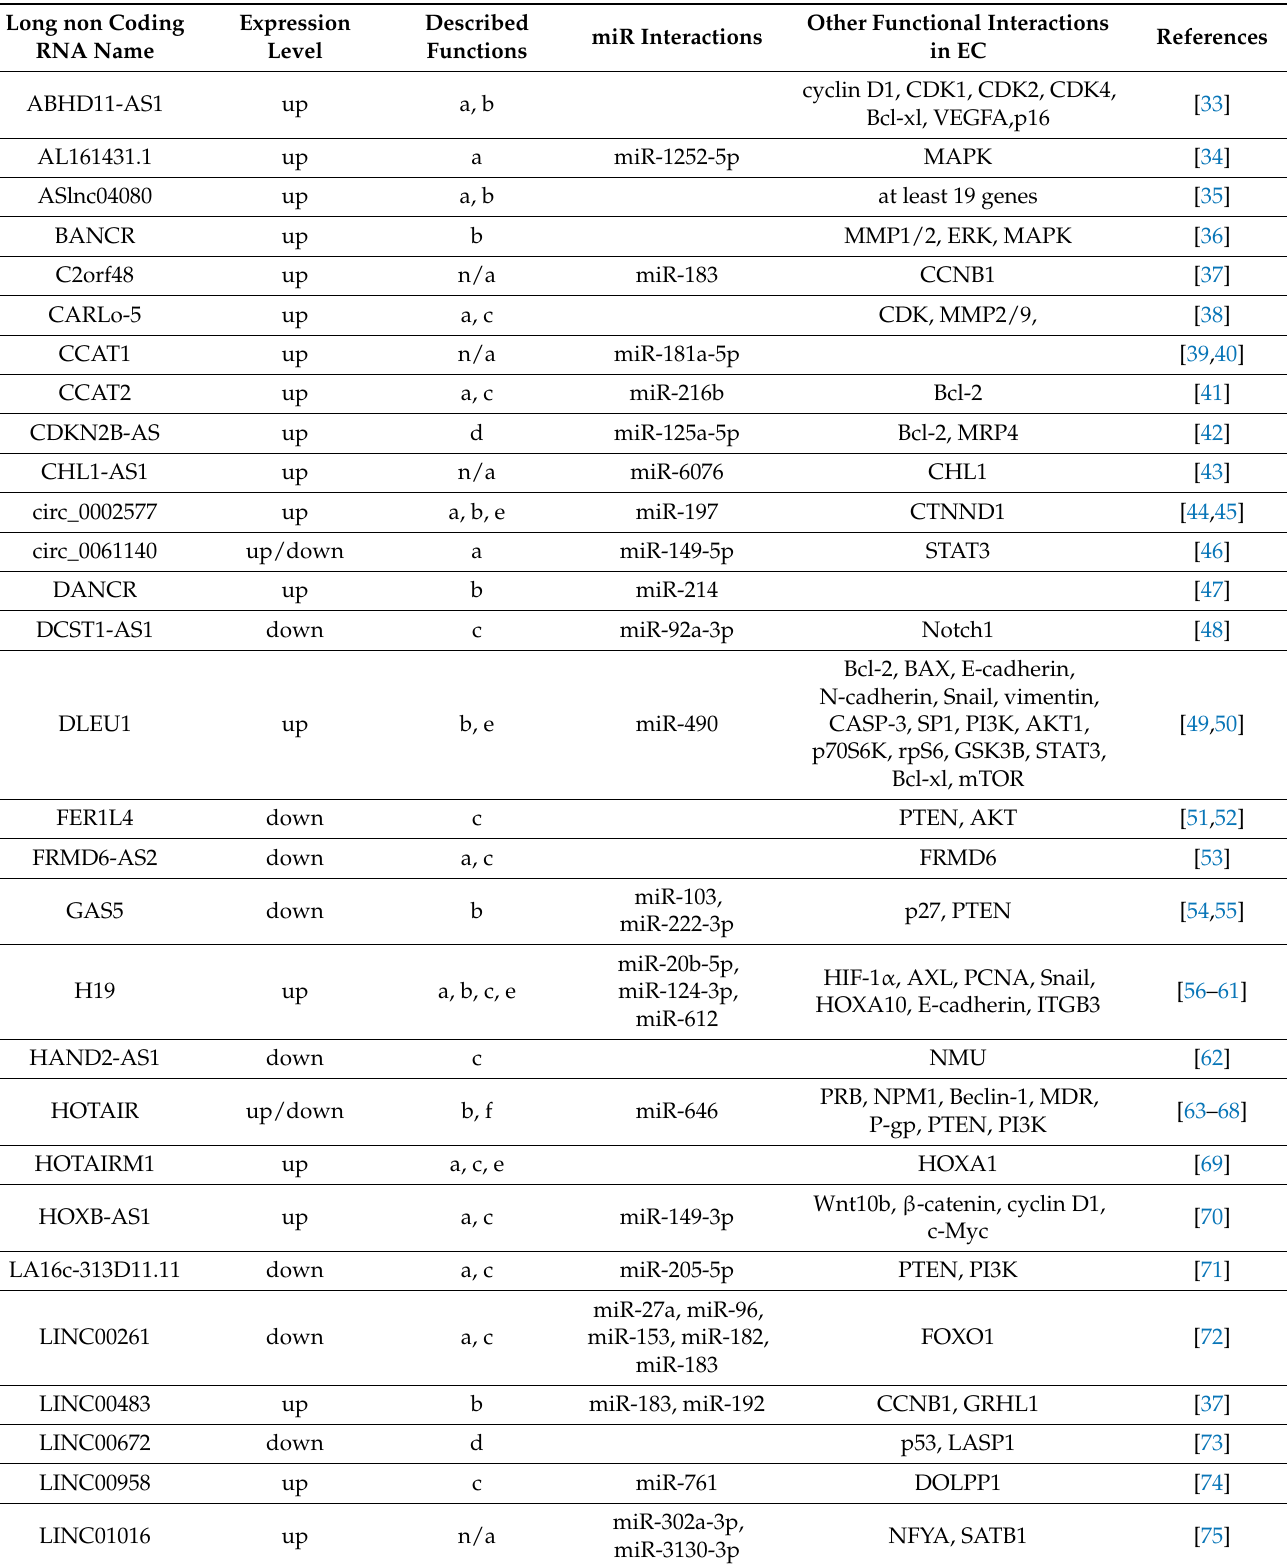
Table 1. A summary of lncRNAs that play a role in endometrial cancer (EC) pathogenesis and for which a functional characterization is